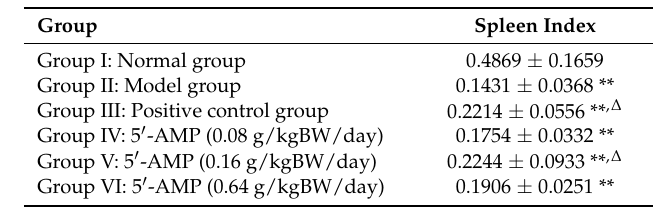
Table 1. Effects of adenosine 5 (cid:48) -monophosphate (5 (cid:48) -AMP) on the spleen organ index of mice treated with γ -radiation ( n = 6).